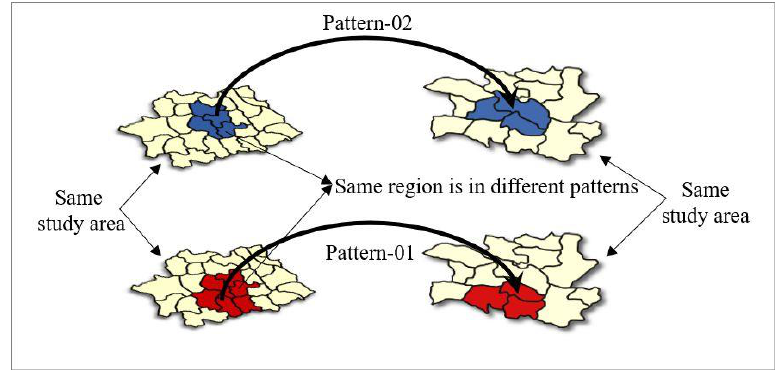
Figure 7. Example of one region belonging to different patterns.